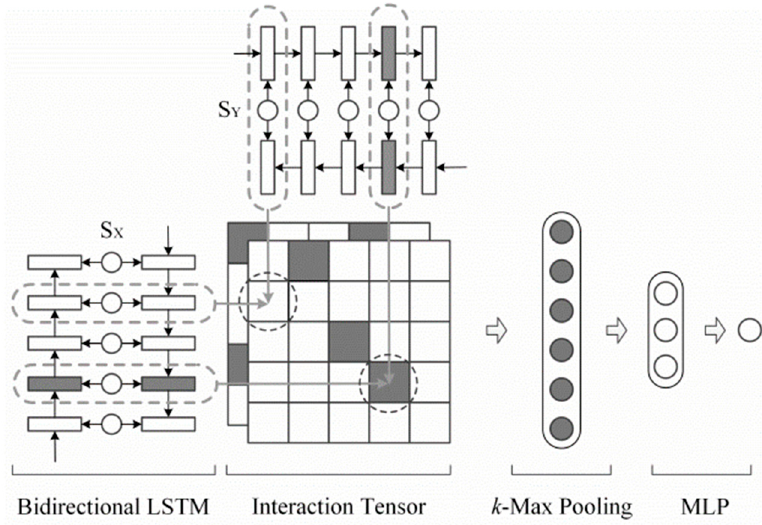
Figure 6. Illustration of multi-view bidirectional long and short-term memory (MV-LSTM) [51].